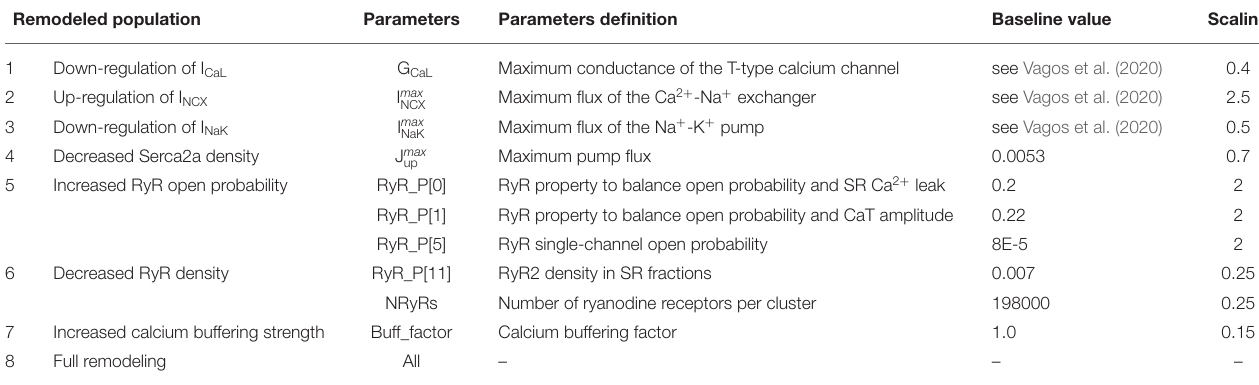
TABLE 1 | List of the 8 different RAP-induced remodeled populations, and the parameters changed in the rabbit atrial myocyte model to represent remodeling in each case. Remodeled population